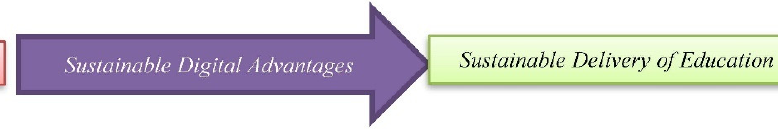
Figure 4. The fundamental model of postmodernism on sustainable digital transformation. Source: Based on the author’s proposal (2022).